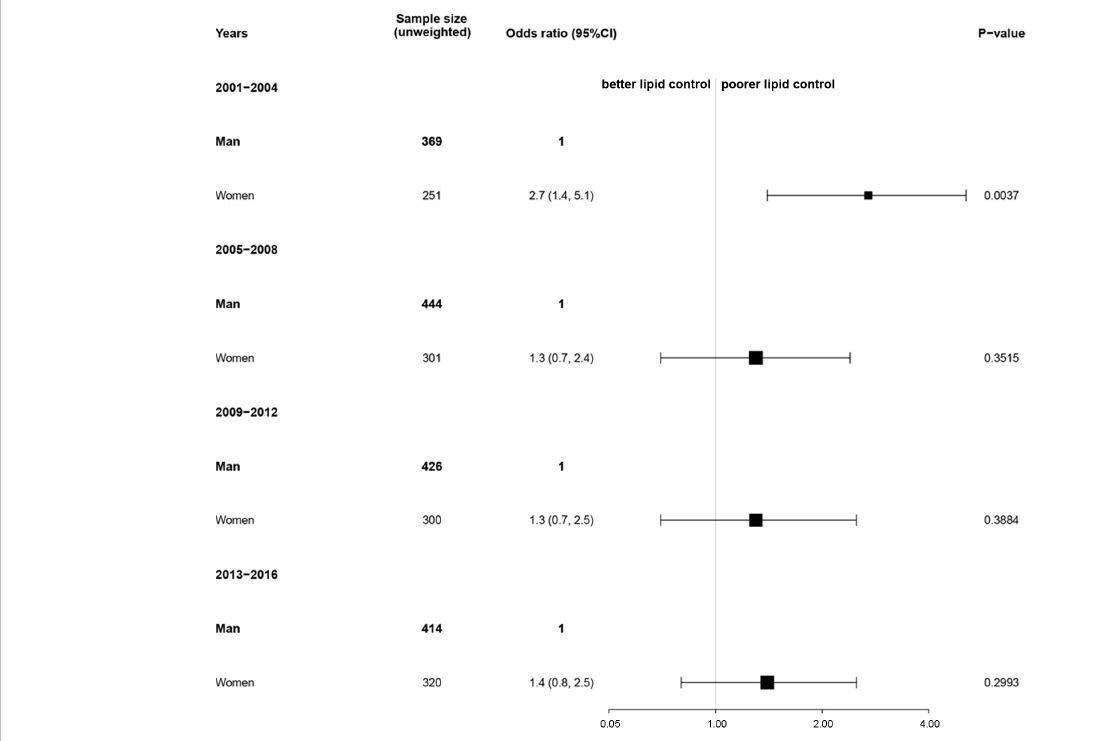
FIGURE 3 Association of sex with lipid control among survivors of stroke and/or myocardial infarction. Nationally representative estimates of the survivors of stroke and/or myocardial infarction aged ≥ 20 years in NHANES from 2001 to 2016 (n=3,245, representing a weighted total population of 97,726,894). Poor or good lipid control was de fi ned as total cholesterol > 200 mg/dL or not, respectively. The reference group was men. An odds ratio > 1 indicates a higher rate of poor lipid control.